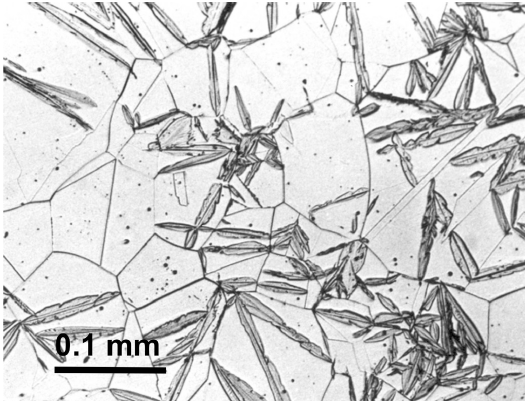
Fig. 1 – Light micrograph showing the microstructure of a coarse-grained austenite of a Fe-31wt%Ni-0.02wt%C alloy transformed at M = 220 K. (Courtesy of J. R. C. S